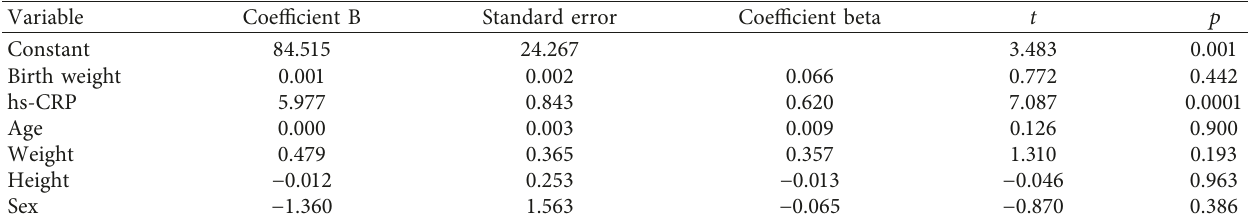
Figure 8: Scatterplot diagram for the association between hs-CRP level and diastolic blood pressure. Table 6: Relationship of hs-CRP and birth weight with systolic blood pressure with control variables such as child’s age, sex, weight, and height.